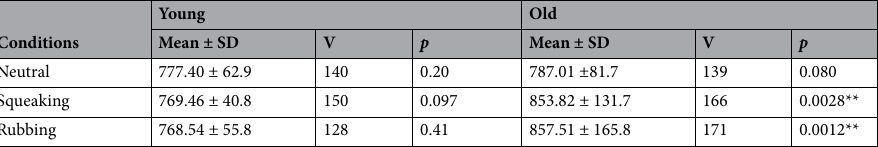
Table 2. Comparisons of the PSE values with the reference texture value (750 nm) using Wilcoxon tests for the three texture conditions in the Young and Old groups. * p < 0.05; ** p < 0.01.